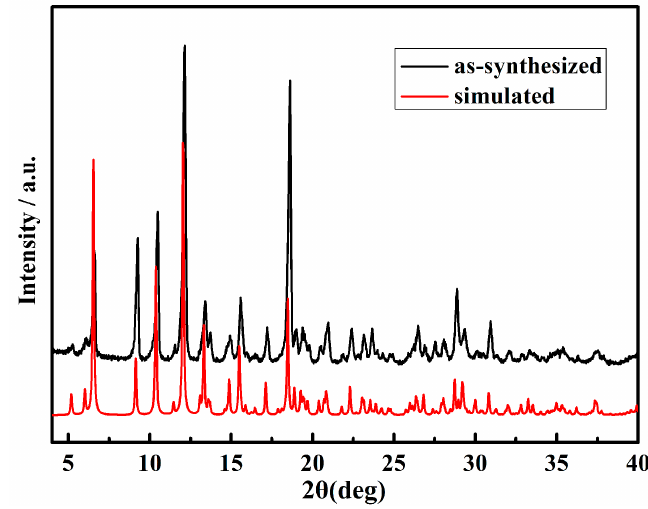
Figure 4. Powder X-ray diffraction of JUC-112.